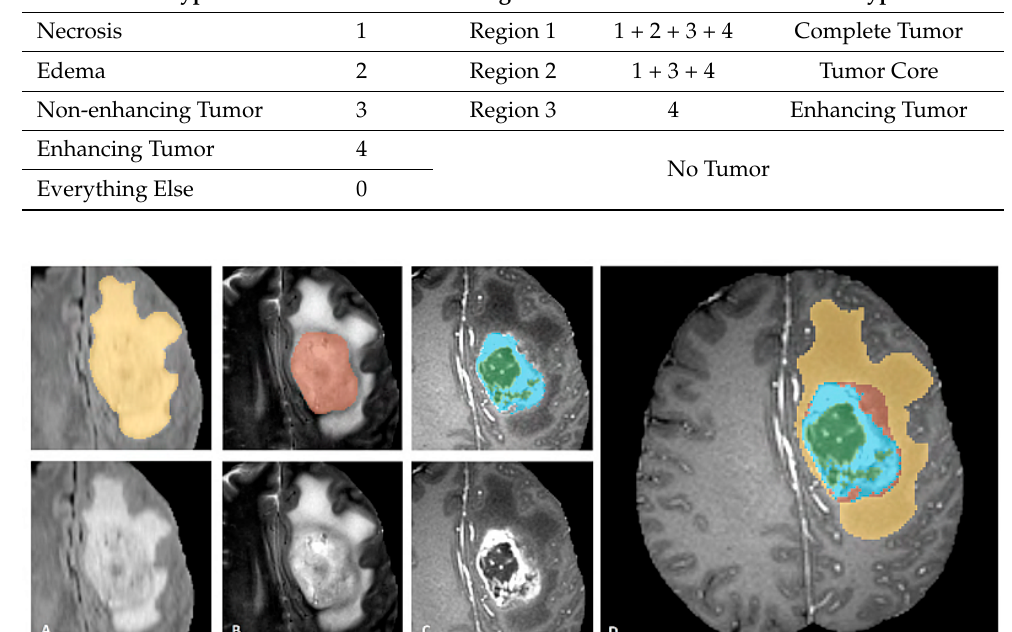
Figure 7. Sample of Multiclass Glioma labels with different modalities. The image label shows: ( A ). Whole tumor, ( B ). Tumor core, ( C ). Enhancing Tumor and ( D ). Combined all tumor types [22]. Table 3. BraTS Annotations and Sub Compartments.